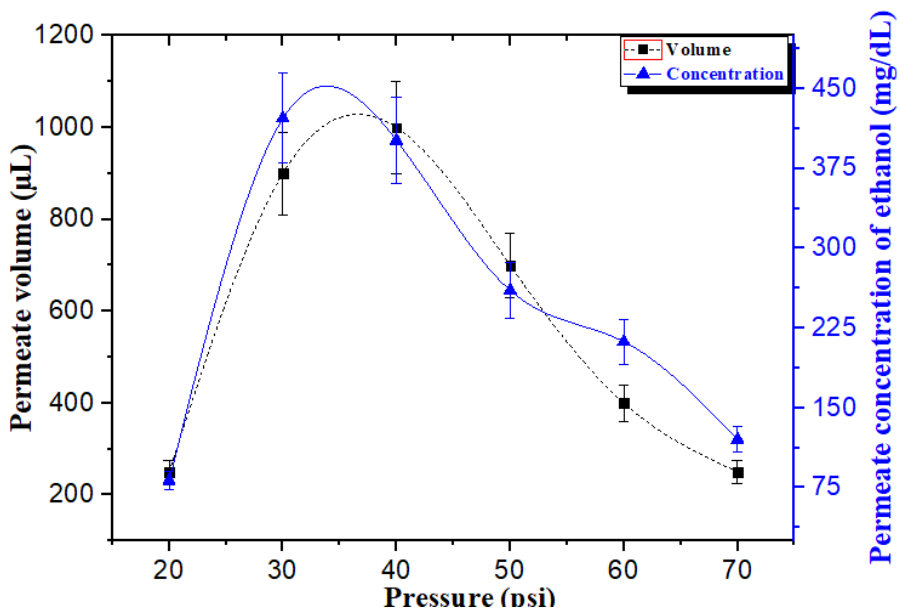
Figure 13. Separation process of fermentation broth using poly (MMA- co -MA) membrane under different nitrogen pressures.